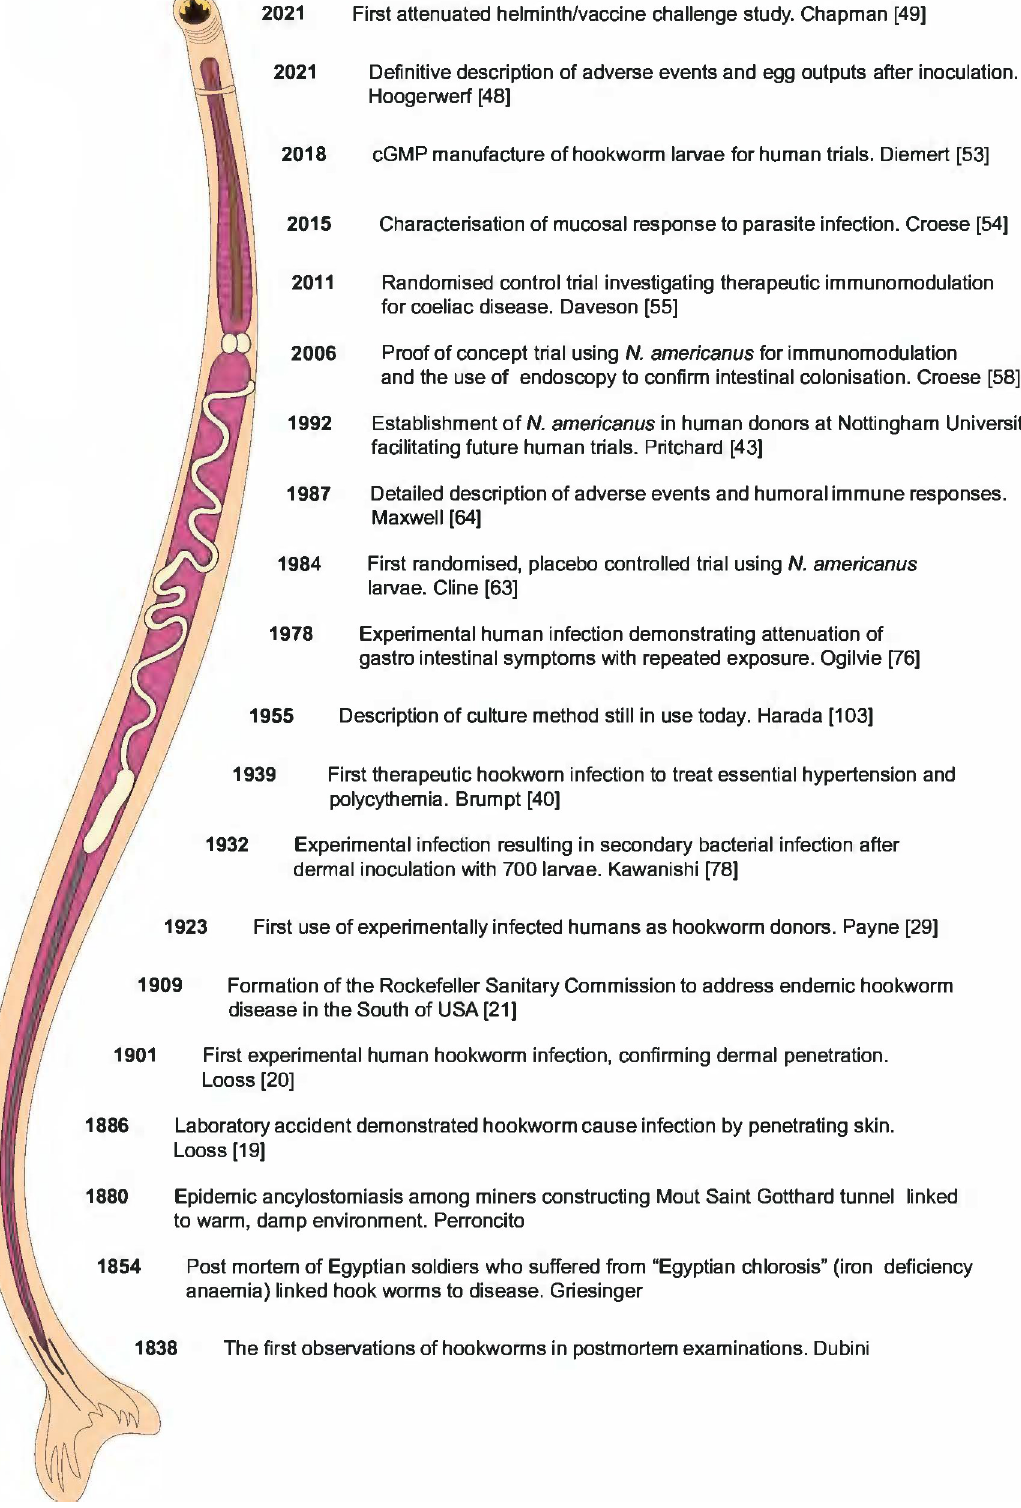
PLOS NeglectedTropical Diseases | https://doi.org/10.1371/journal.pntd.0009908 December9, 2021 3 /